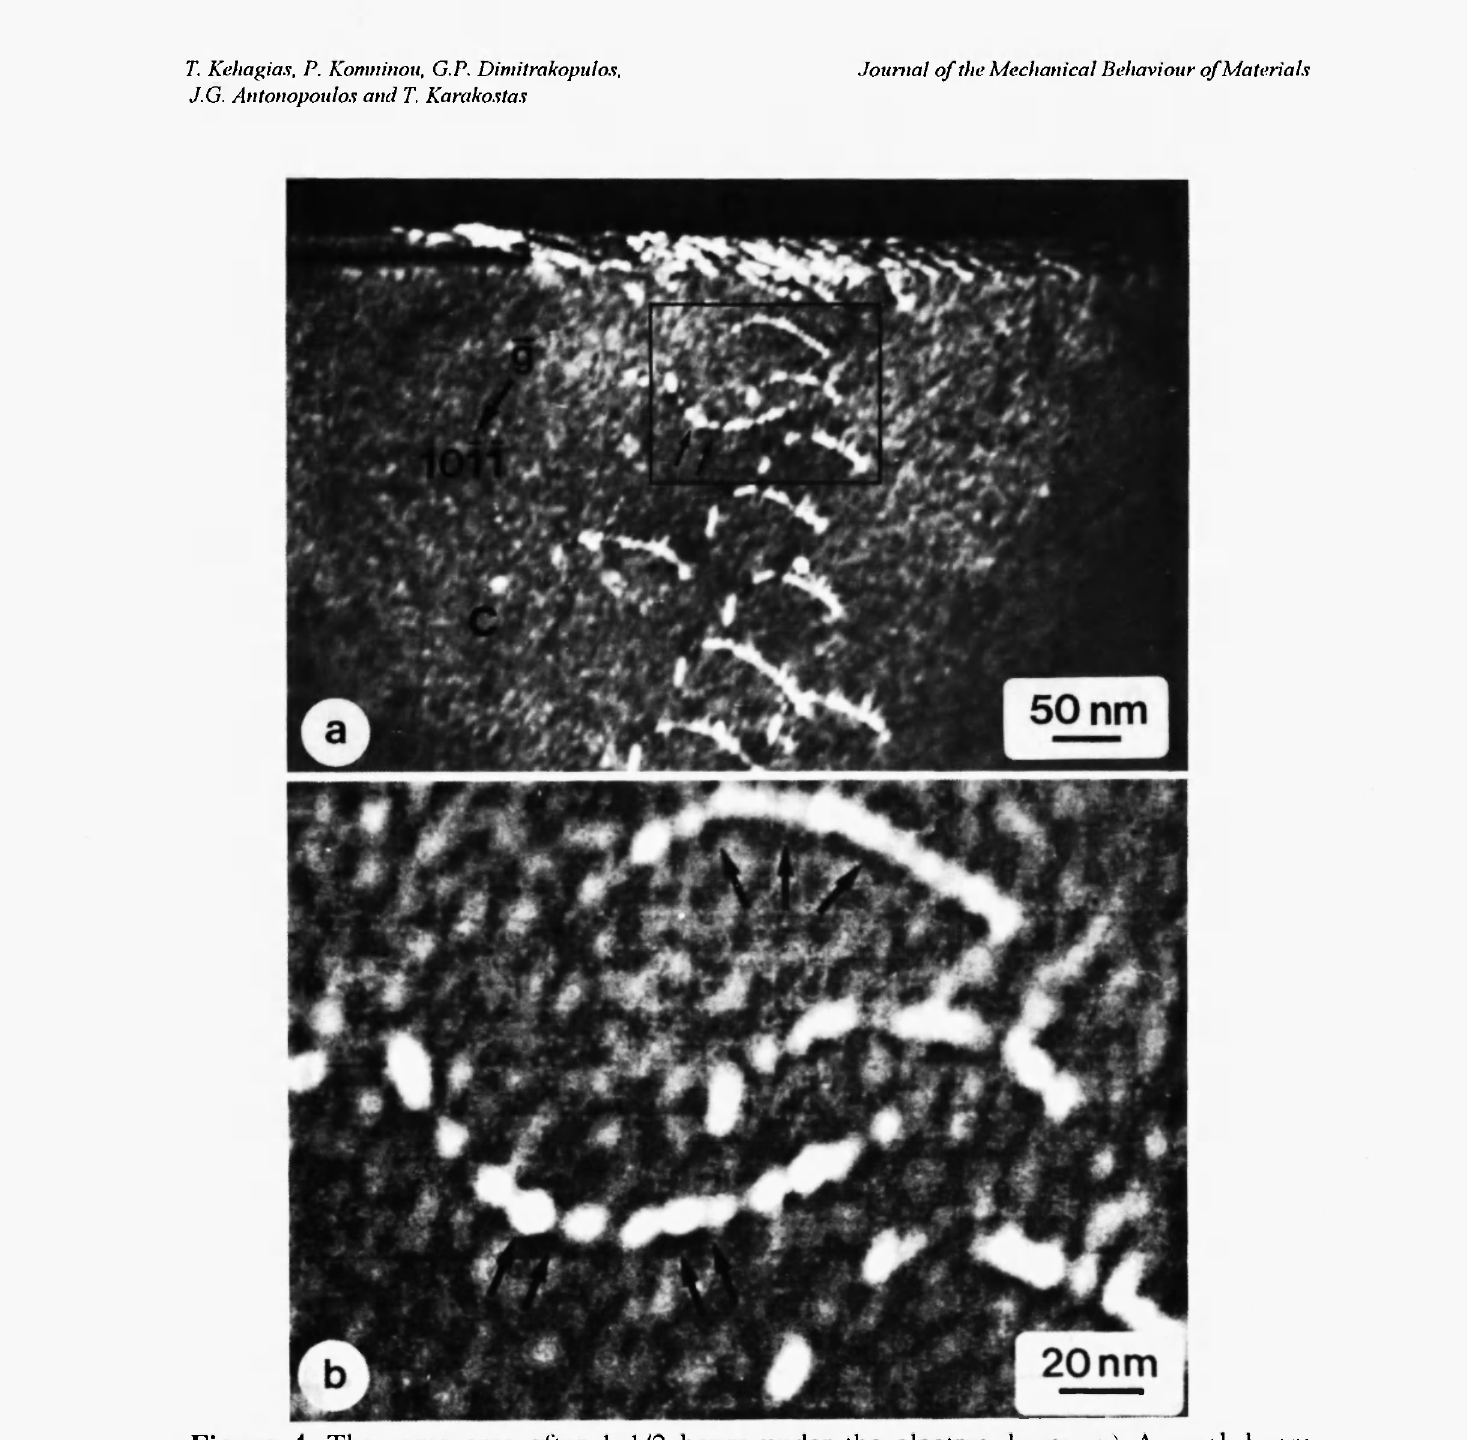
Figure 4. The same area after 1 1 /2 hours under the electron beam, a) A weak-beam (g/3g) image, where a second reflected dislocation is identified by small arrows; there is indication that the contrast side of all dislocations lies on the same side in respect to their lines, b) Magnified image after image processing corresponding to the box of Fig. 4a, where the arrows indicate the dark contrast of the dislocation lines of both incident and reflected